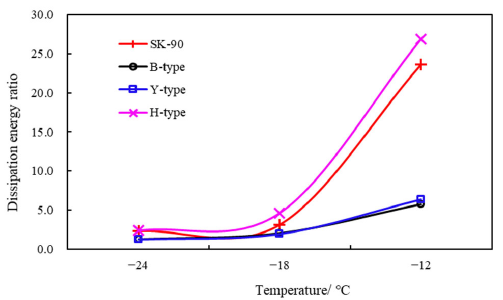
Figure 6. Dissipation energy ratio of the binders under different temperatures.